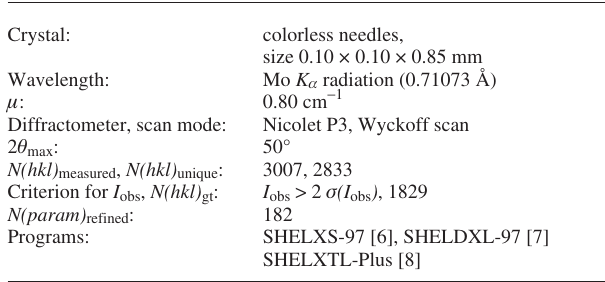
Table 1. Data collection and handling.